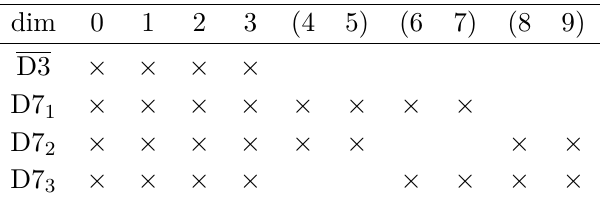
Table 1 . Table indicates how 3 stacks of D7-branes can appear, each with SU( N i ) × U(1) i symmetry, i = 1 , 2 , 3 . Placing the 4-cycles to lie mostly in the dimensions shown, the gaugino condensates can provide 3 non-perturbative terms. 0 -dim refers to the time and others refer to spatial dimensions. The Racetrack Kähler Uplift model requires 2 or more such